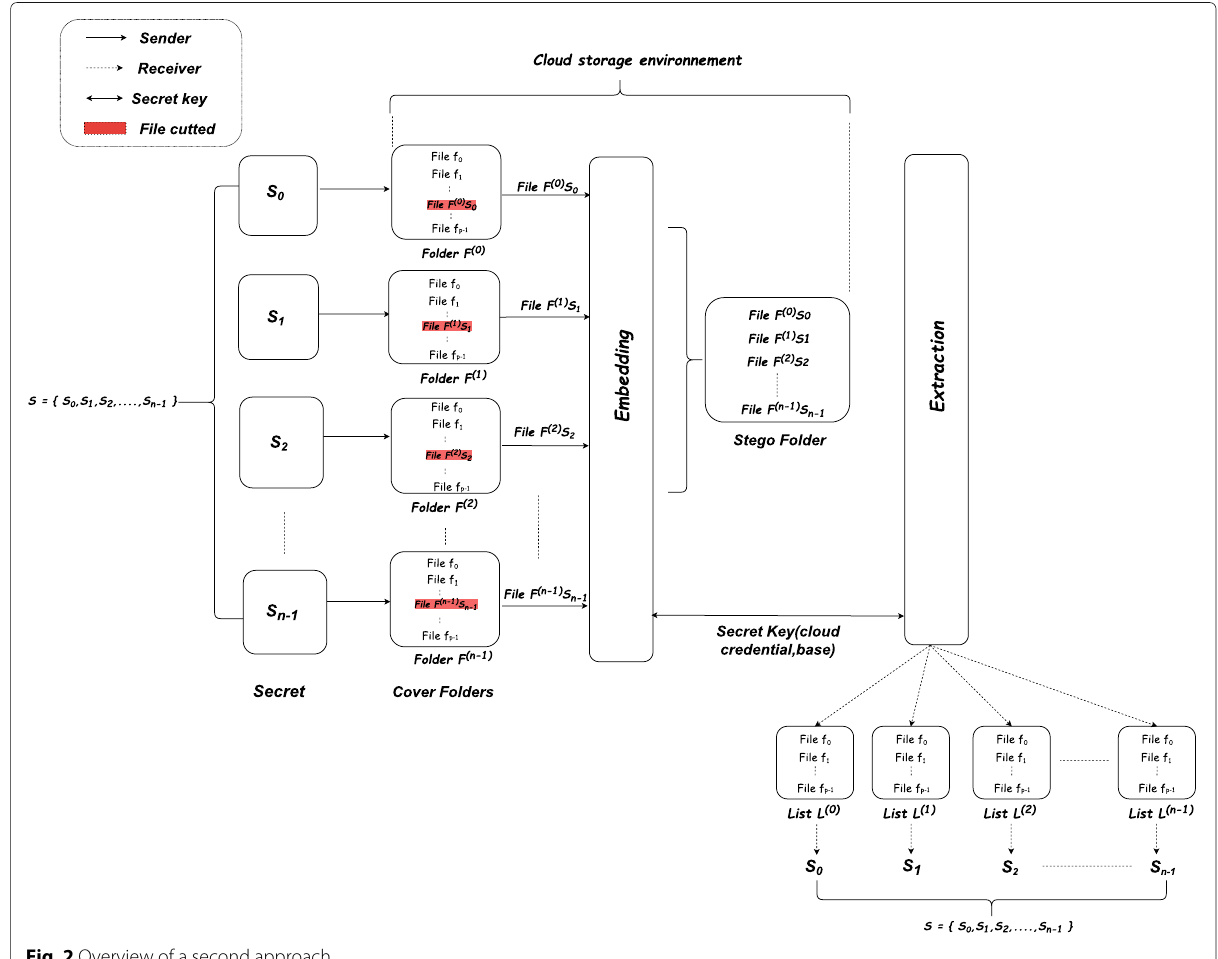
Fig. 2 Overview of a second approach